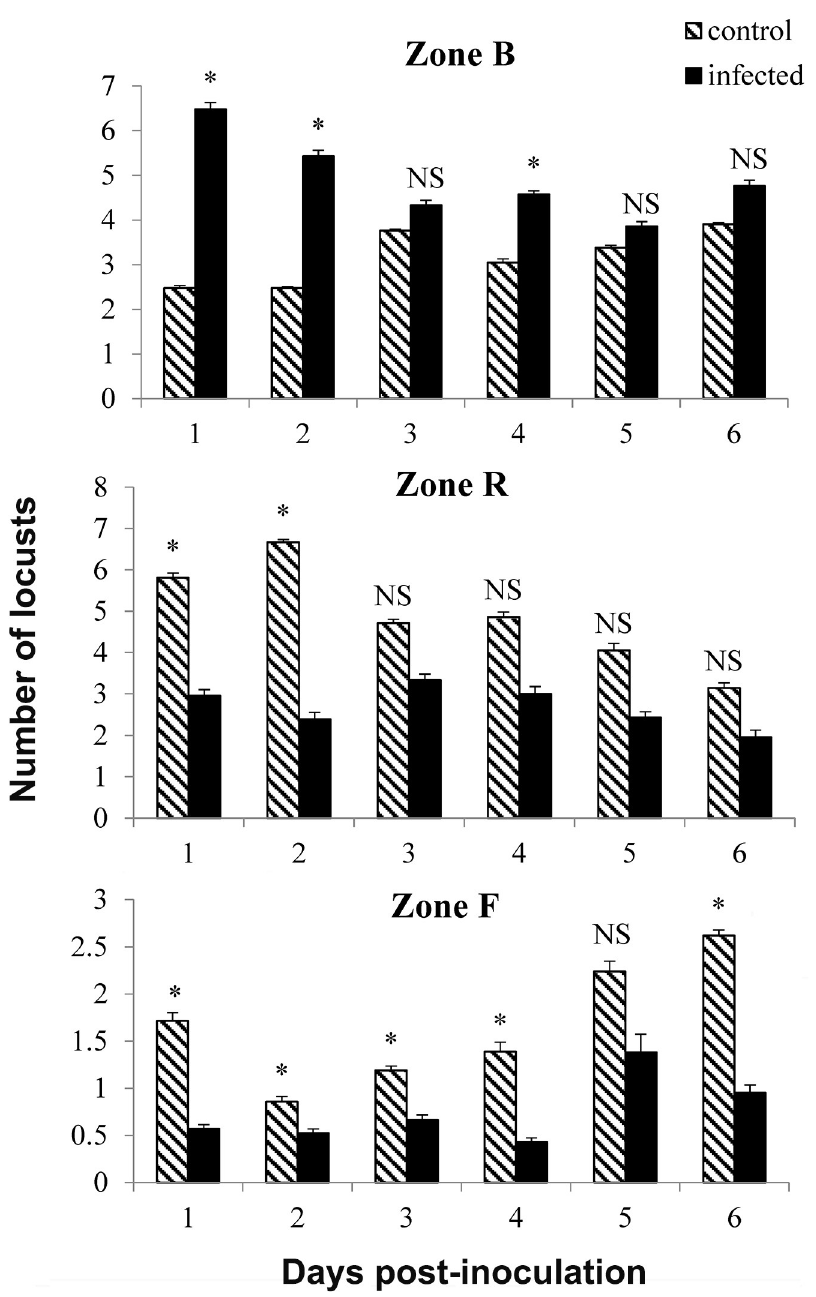
Fig 3. Distribution of infected and uninfected locusts in feeding, basking and resting zones. Distribution of control and inoculated Beauveria bassiana -infected Locusta migratoria manilensis (10 4 spores/5 th instar nymph) in zone F (feeding), zone B (basking) and zone R (resting). An asterisk denotes a significant difference between infected and non-infected insects ( P < 0.05), and NS indicates no significant difference. n = 10 locusts per treatment.